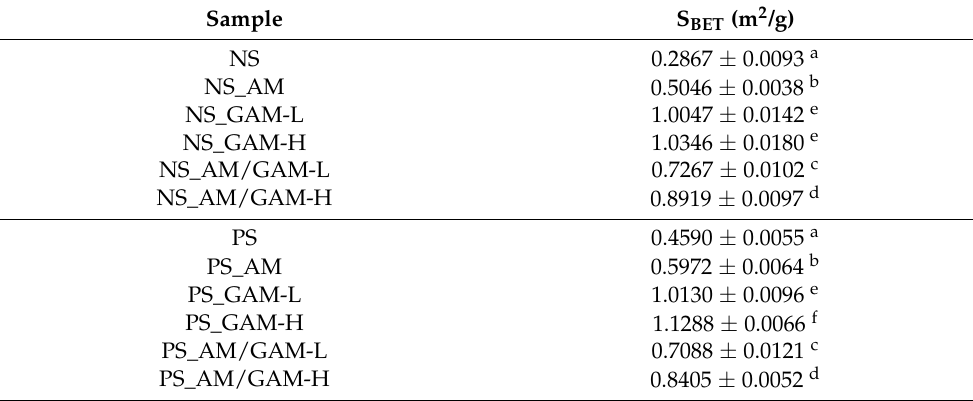
Table 2. Specific surface area determination.